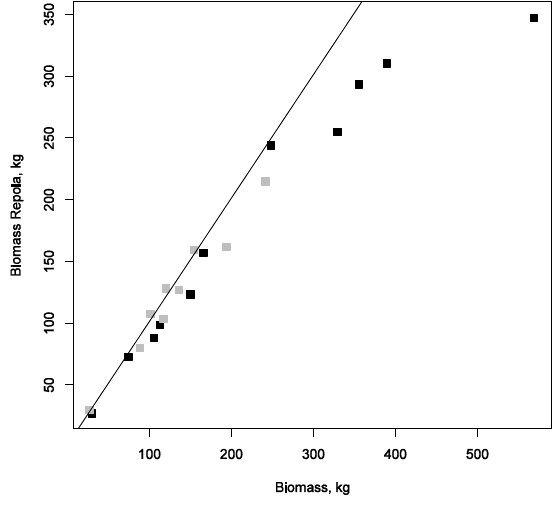
Figure 4. Tree biomasses predicted (Repola 2009) vs. field